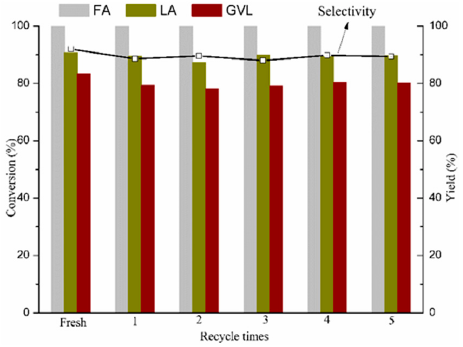
Figure 7. The recyclability of catalyst (Reaction conditions: 22.4 mmol LA, 22.4 mmol FA, 50 mL H 2 O, 0.25 g catalyst, 240 °C and 2 h).